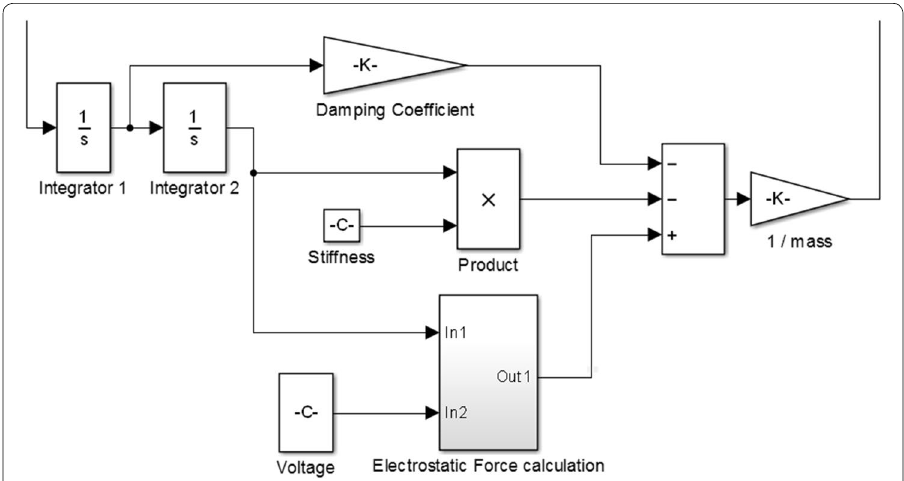
Fig. 2 Parallel plate actuator Simulink